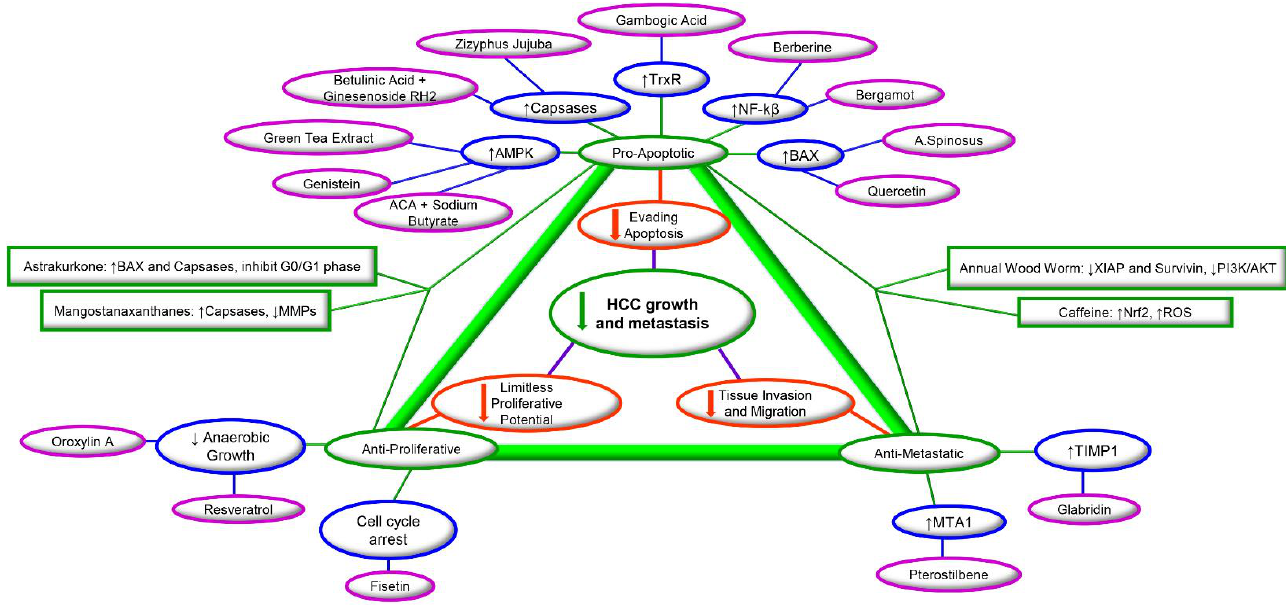
Figure 1. Phytochemicals and their mechanisms to target HCC metastasis are shown here. Phytochemicals effect the major processes of HCC metastasis, such as cell cycle, proliferation, migration, invasion, and apoptosis by targeting key molecular markers involved in these processes.